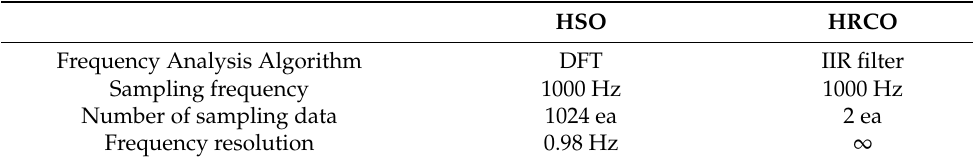
Table 2. Parameters of HSO and HRCO.